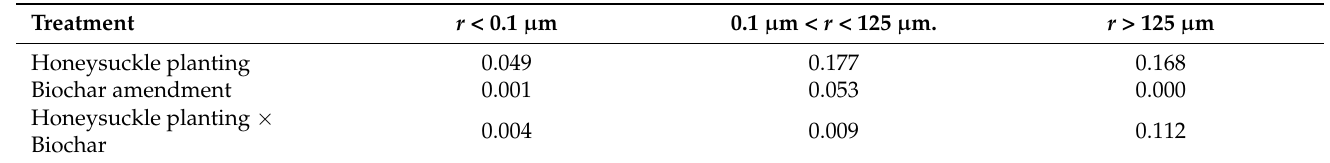
Table 6. P values of the interaction between honeysuckle planting and biochar amendment on soil pores estimated by